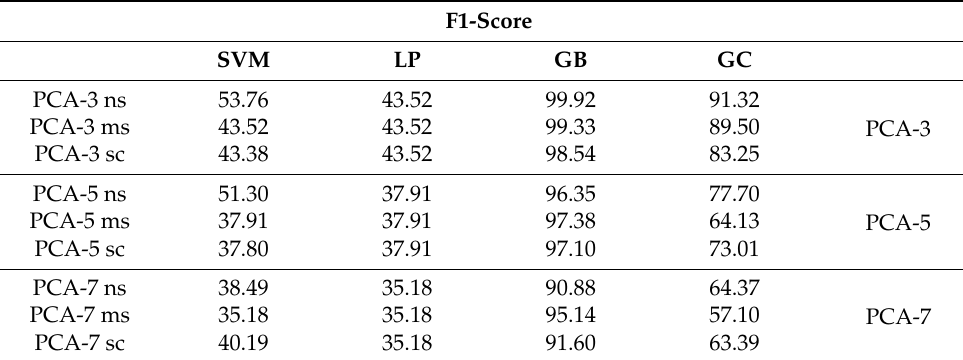
Table 6. The F1 score for classification of CyanoHAB HSI using PCA 3, 5, and 7 bands with the three types of scaling using the four machines.